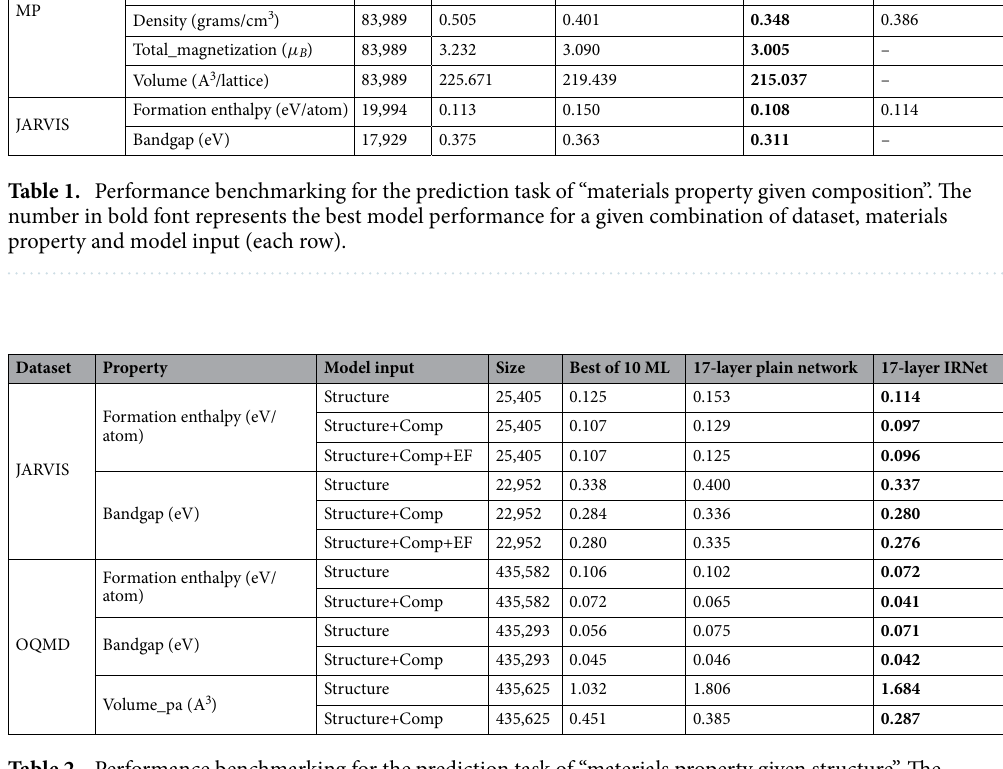
Table 2. Performance benchmarking for the prediction task of “materials property given structure”. The number in bold font represents the best model performance for a given combination of dataset, materials property and model input (each